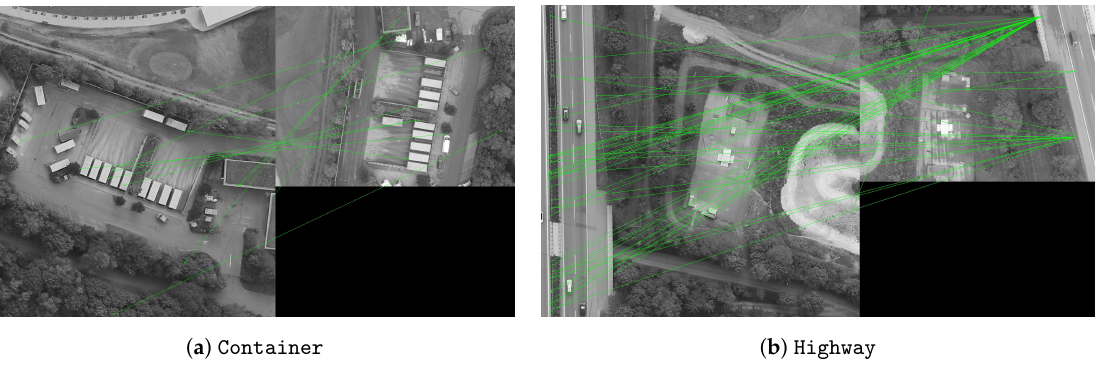
Figure 1. Typical cases from the datasets ( a ) Container and ( b ) Highway showing the results of matching UAV and aerial images using SIFT, where the left of the subfigure is a downsampled UAV image and the right is a cropped aerial image. Green lines indicate the matches detected by SIFT; almost all of them are